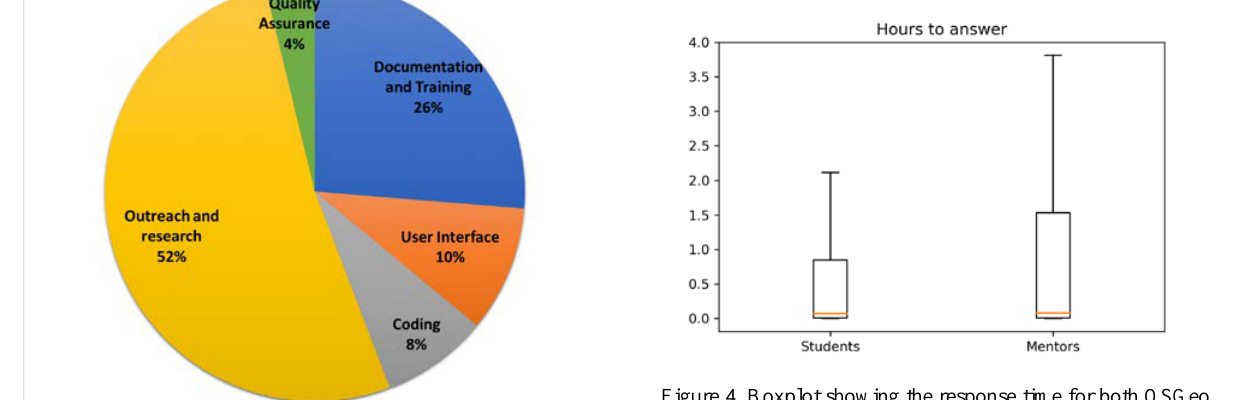
Figure 4. Boxplot showing the response time for both OSGeo mentors and students OSGeo and pgRouting had the highest number of completed tasks, followed by OSGeo-Live and GRASS GIS. GRASS GIS (refer to Figure 5).